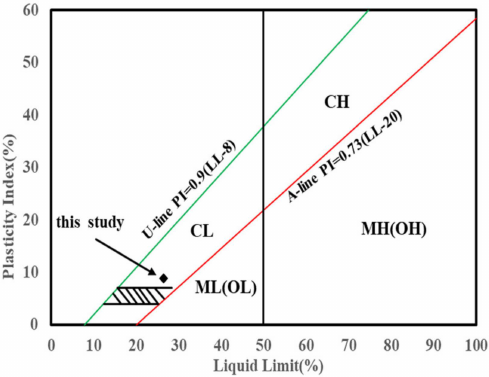
Figure 5. Testing soils in the paper located within the plastic chart according to the United Soils Classification